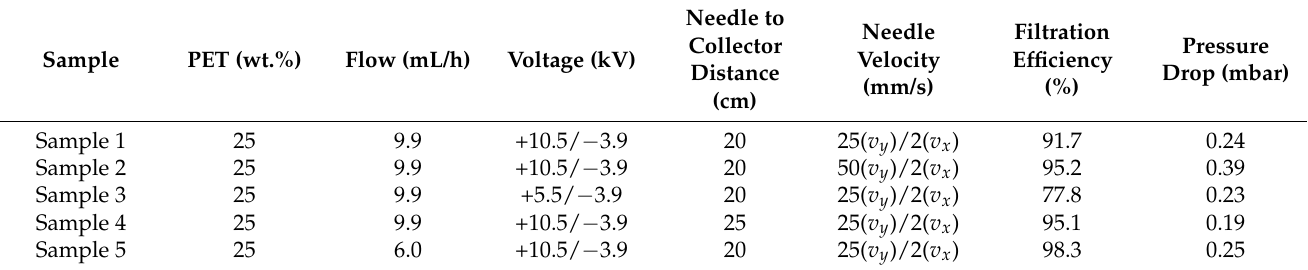
Table 1. Variation of parameters used during electrospinning to evaluate their influence on the filtration efficiency of submicron